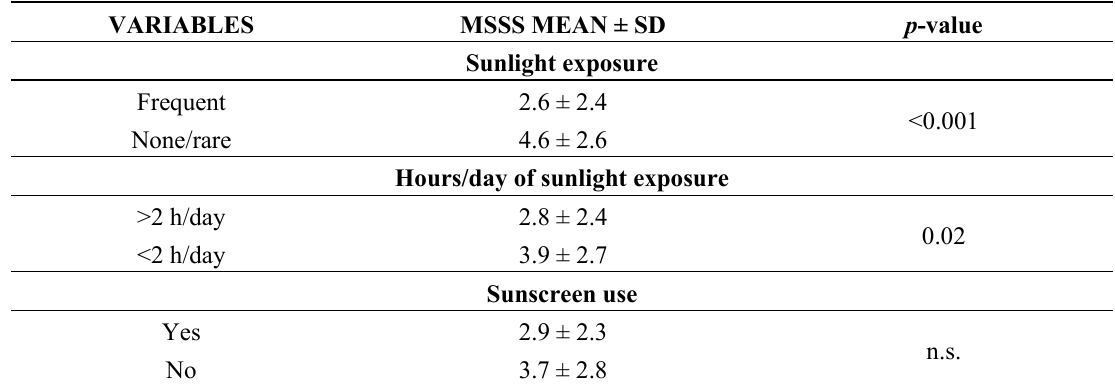
Table 5. Sunlight Exposure and MS Severity (MSSS